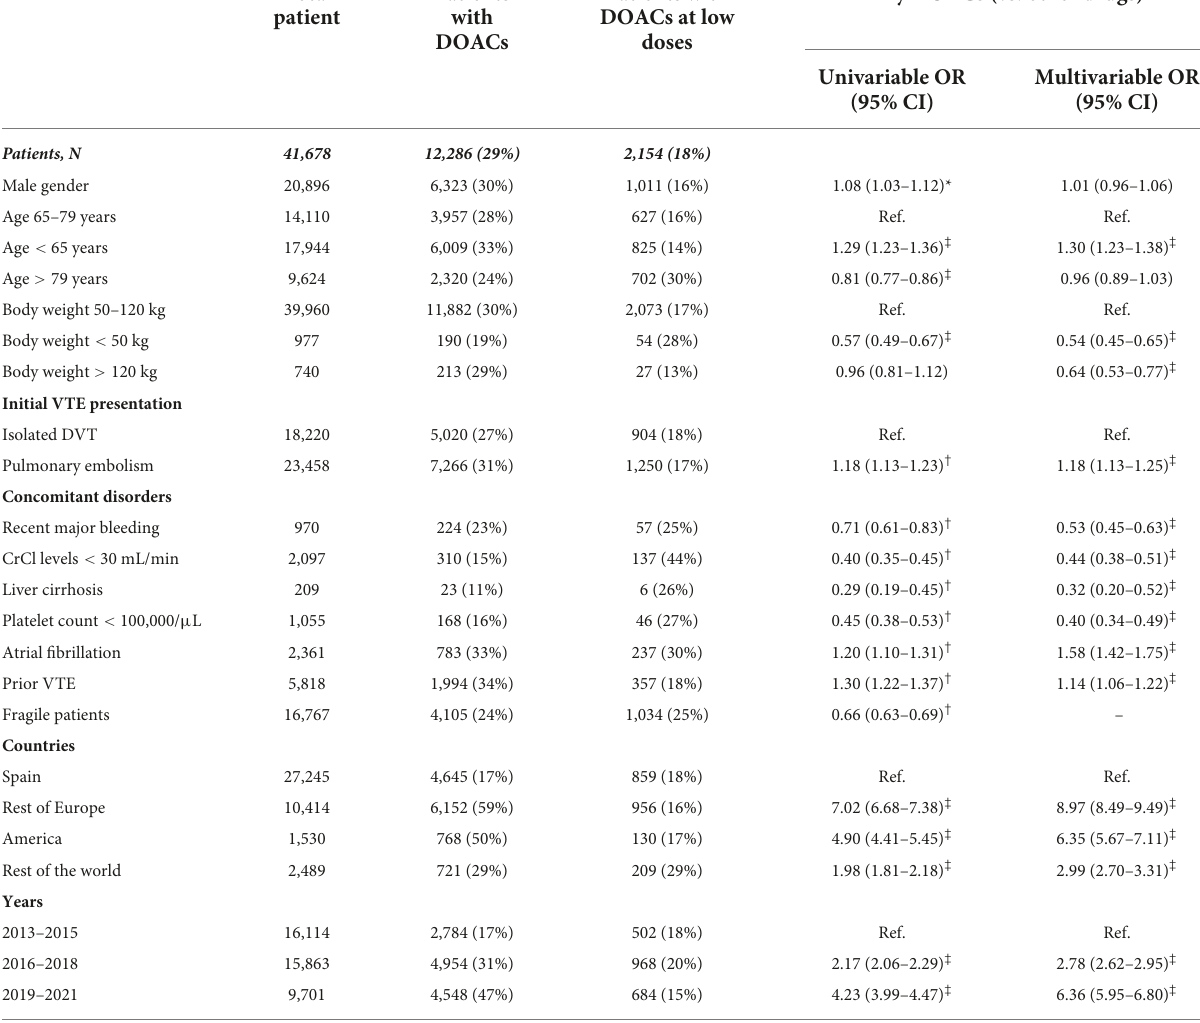
TABLE 2 Univariable and multivariable analyses for predictors of use of DOACs vs. other drugs.